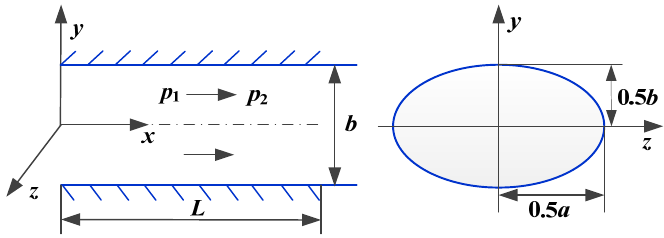
Figure 13. Sketch map of laminar flow in the eclipse tube.